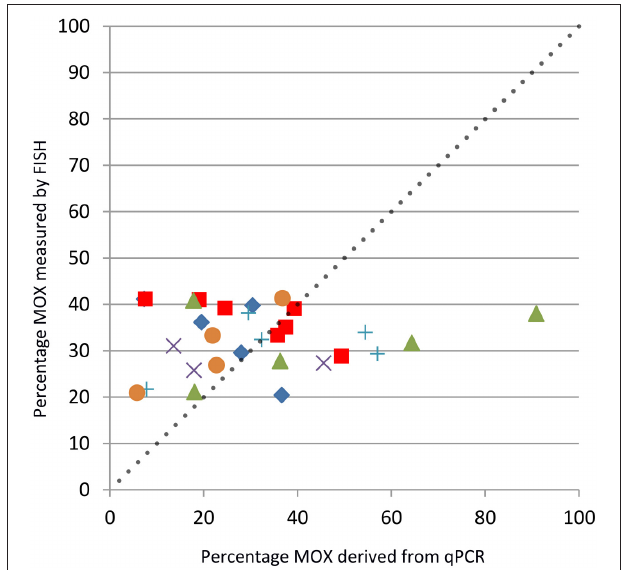
FIGURE 5 | Percentage of the total bacterial area occupied by methane-oxidizers derived from qPCR results (x-axis) vs. percentages measured by FISH on gill filament sections (y-axis). Non-isobaric recovery, blue diamond; isobaric recovery, red square; 5 h water, green triangle; 5 h methane, violet “ × ”; 5h HCO − 3 , blue “ + ”; 5h sulfide and HCO − 3 , orange circle. The dotted line with slope 1 corresponds to the relationship that would be expected if every symbiont contained a single copy of their 16S rRNA-encoding gene, and thus each copy would correspond to a bacterium.